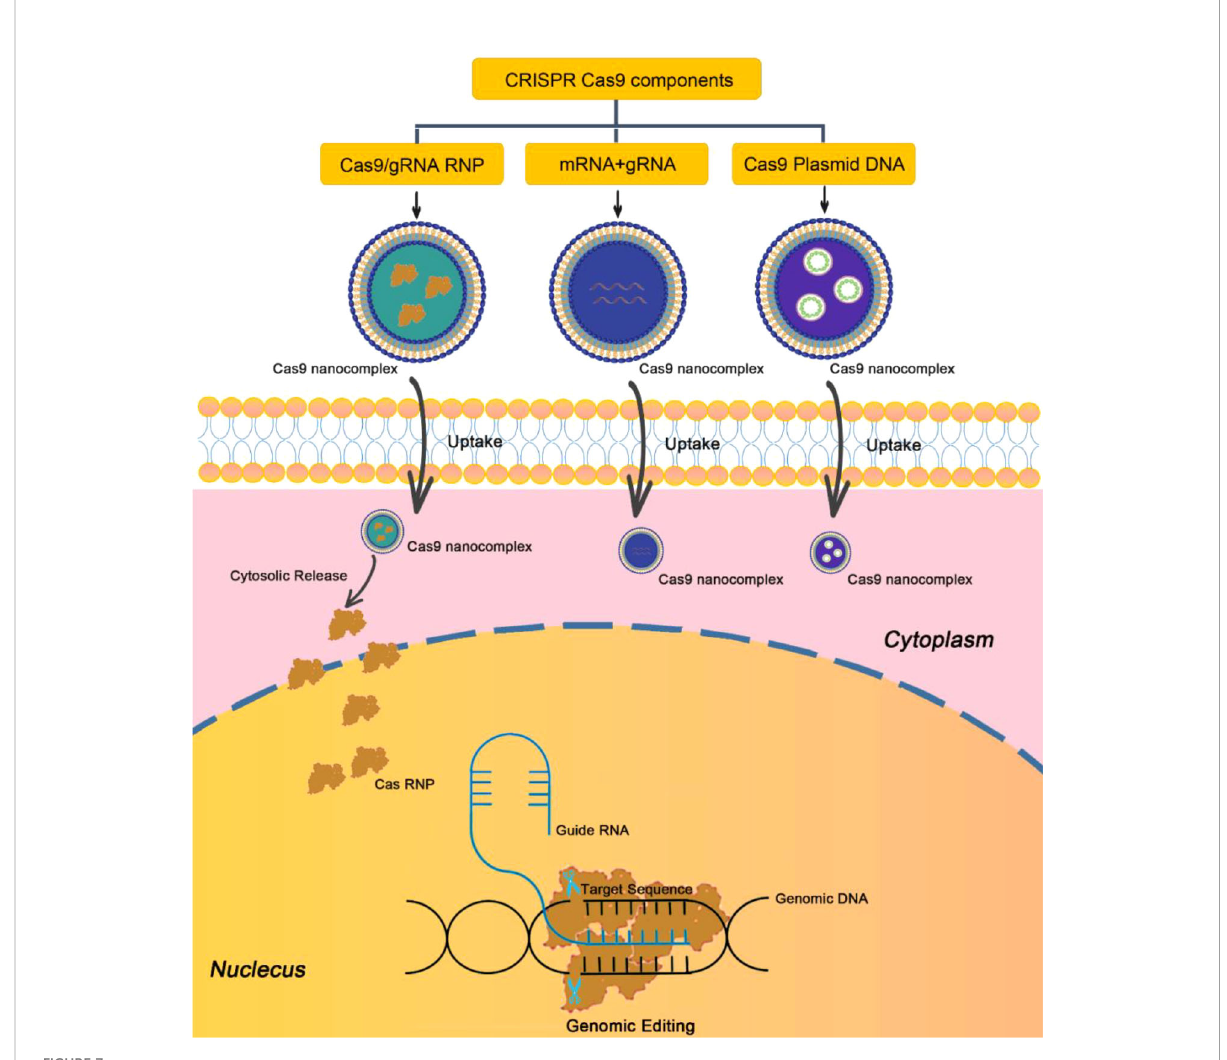
FIGURE 7 Schematic illustration of CRISPR-Cas9 technique for gene